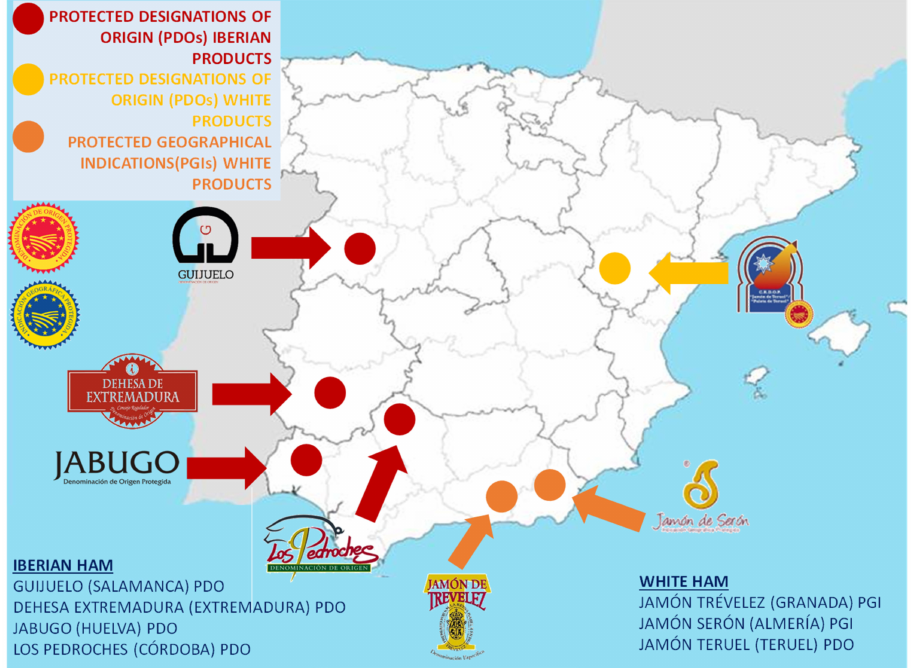
Figure 5. PDO and PGI of ham of Spain. Source: own